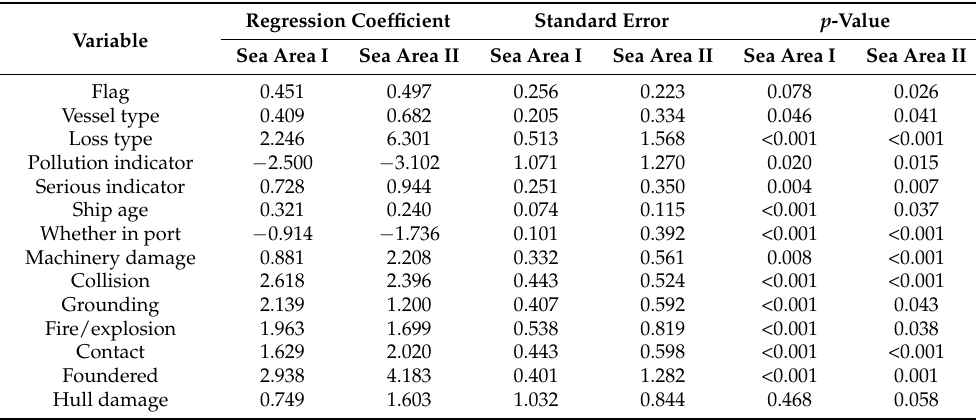
Table 4. Regression parameters of the zero-inflated negative binomial models.